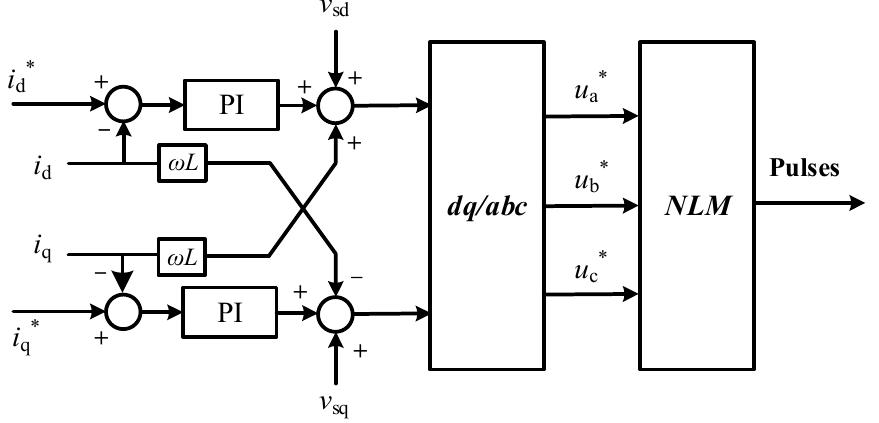
Figure 2. Current-mode control strategy of MMC-BESS.